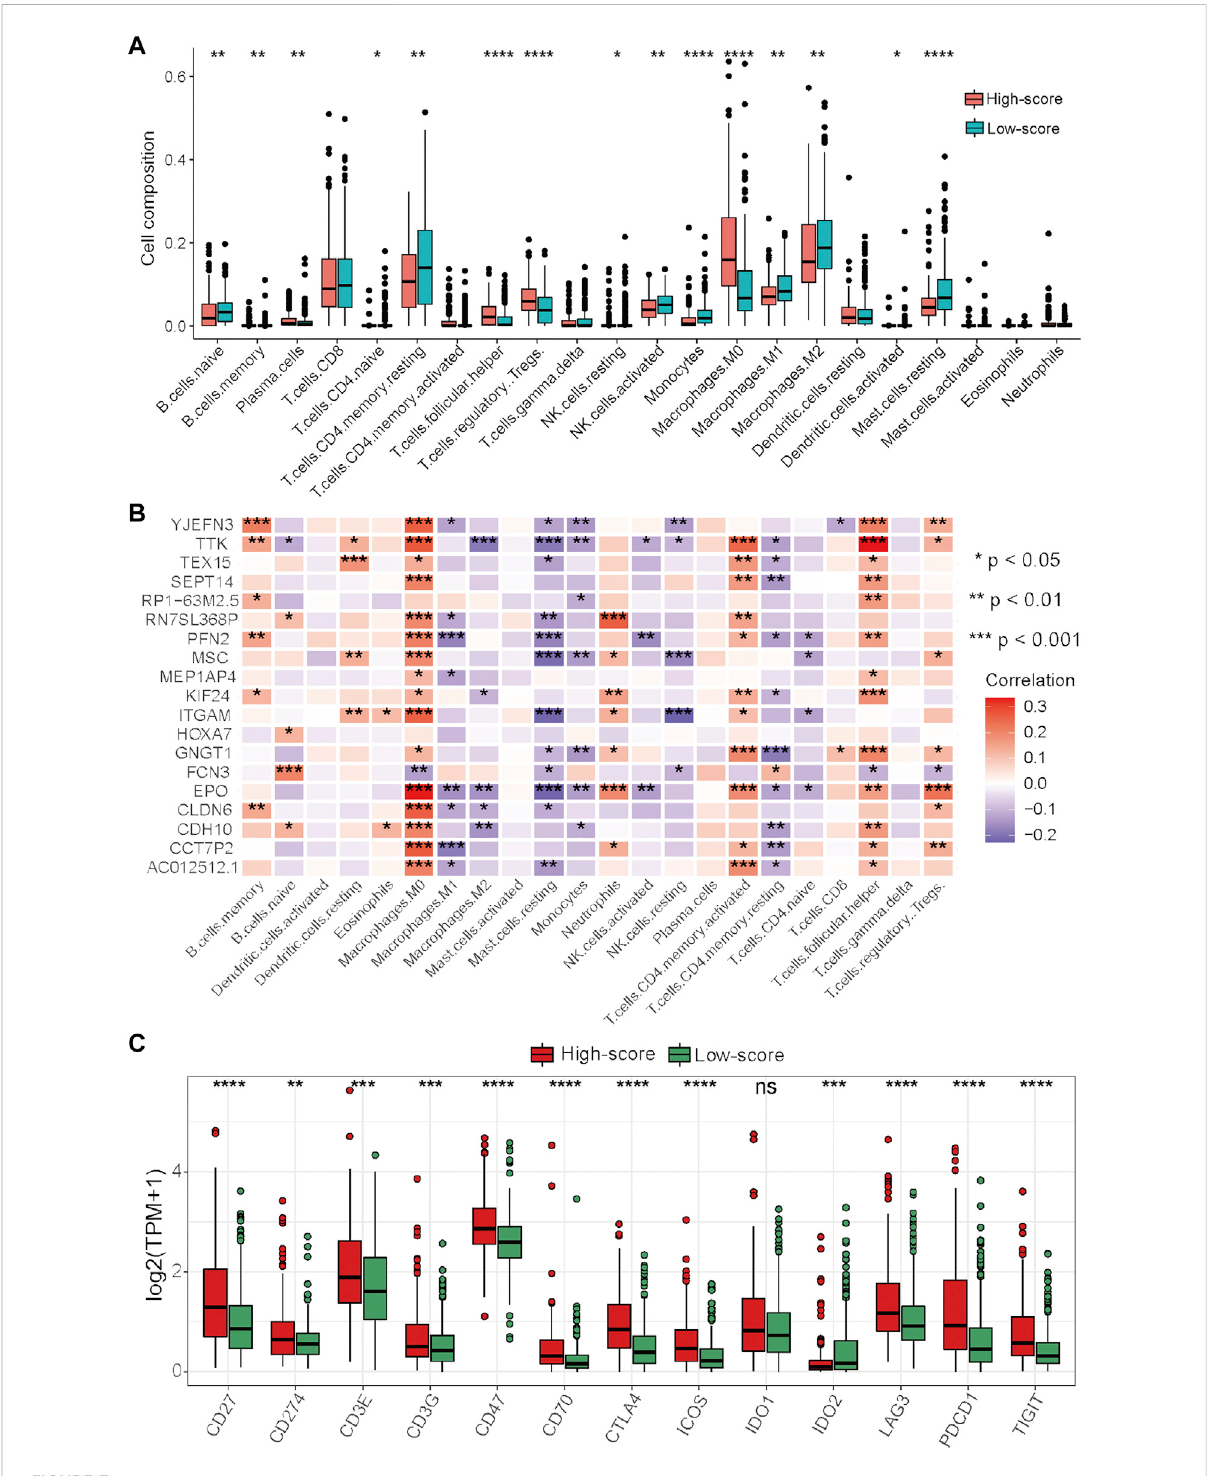
FIGURE 7 Differential analysis of immune characteristics between the two risk groups in the TCGA – HCC cohort. (A) Differences in the 22 immune cell typesbetweenthetworiskgroups. (B) Correlationsbetweenthe19prognosticDEGsfortheestablishmentoftheriskscoreand22immunecells. (C) Differences in the 13 immune checkpoint molecules between the two risk groups. * p < 0.05, ** p < 0.01, *** p < 0.001, and **** p <